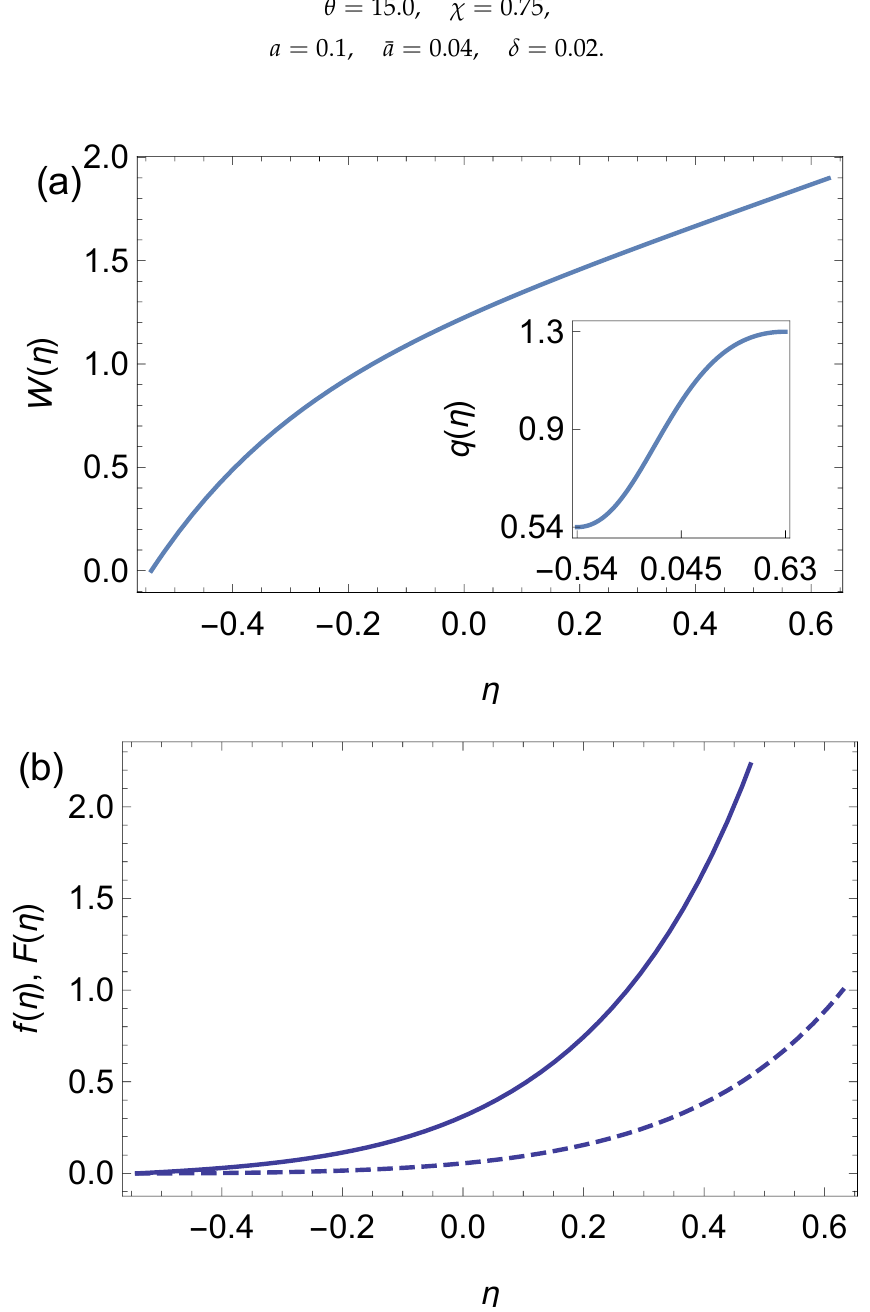
Figure 1. Solutions of the model equations of Section 3 for baseline parameters ρ = 0.06, r = 0.05, σ = 0.2, a = 0.1, ¯ a = 0.04, δ = 0.02, θ = 15 and χ = 0.75. Subfigure ( a ): value function W , inset shows the function q over the same η range; ( b ) the ergodic density f (solid curve) and the cumulative density function F